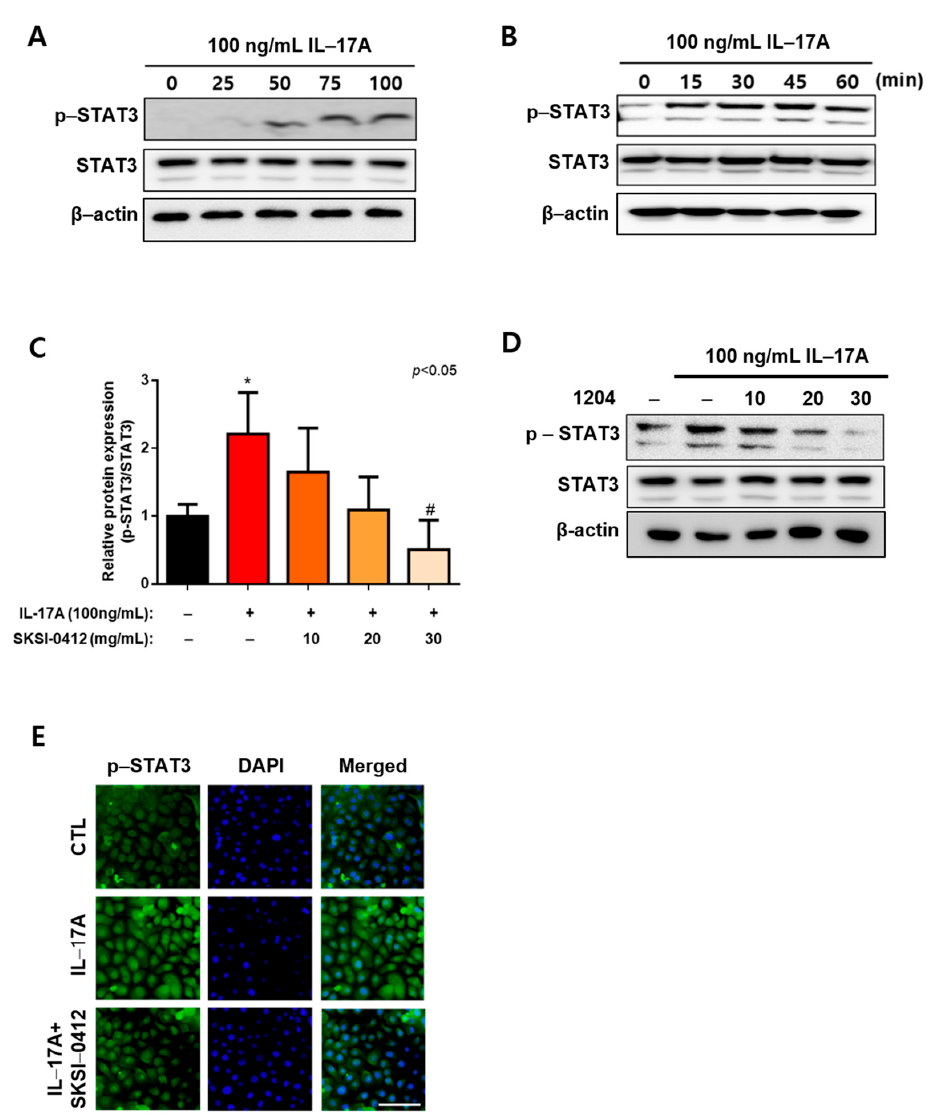
Figure 2. SKSI ‐ 0412 inhibits IL ‐ 17A ‐ induced STAT3 Tyr705 phosphorylation in KCs. ( A , B ) The activation of STAT3 was induced by IL ‐ 17A. Human primary KCs were treated with ( A ) various concentrations of IL ‐ 17A or ( B ) 100 ng/mL IL ‐ 17A for the indicated times. ( C ) RT ‐ PCR, ( D ) Western blot, and ( E ) immunofluorescence results of KCs treated with IL ‐ 17A and SKSI ‐ 0412 for 15 min. SKSI ‐ 0412 dis ‐ regulated STAT3 activation in IL ‐ 17A ‐ induced human primary KCs. The results are expressed as relative enrichment and are shown as mean ± SD of the three keratinocyte cultures. * p < 0.05 compared with nontreated control; # p < 0.05 compared with IL ‐ 17A treatment sample, ANOVA one ‐ way test. ( C ) Location of p ‐ STAT3 was confirmed by immunofluorescent staining of p ‐ STAT3 Tyr 705 in KCs at 15 min. IL ‐ 17A induced the accumu ‐ lation of STAT3, but SKSI ‐ 0412 reduced p ‐ STAT3 in the cytosol and